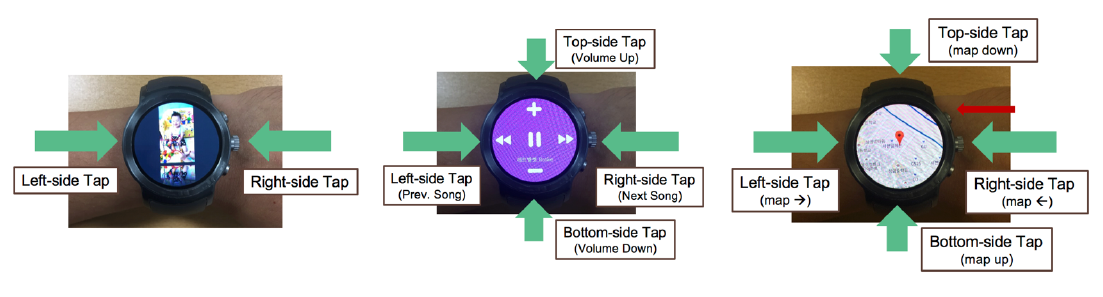
Figure 13. Motion UI-based gallery app, music player app and map app running on a